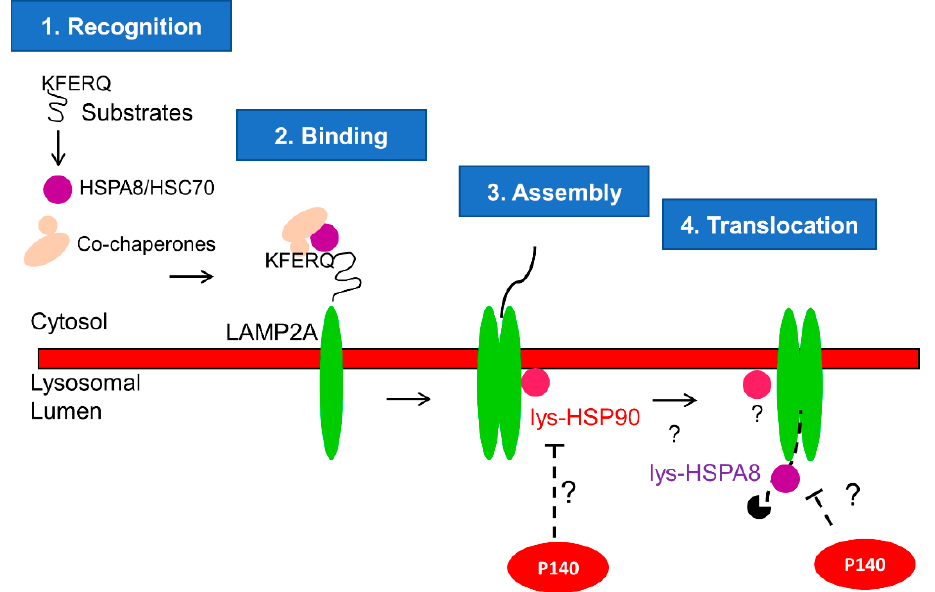
Figure 4. Proposed mechanism of P140 on CMA: CMA is a complex multistep process as described elsewhere in detail [17,18,36]. Here we focus on the CMA steps where P140 could play a role. Our results in this paper strongly suggest that P140 inhibits the substrate uptake step of CMA. The co-localization of P140 and HSPA8 was demonstrated earlier [24,27] by fluorescence and electron microscopy. It was not possible, however, to definitively determine that both co-localize into lysosomes or endosomes [27]. P140 interaction with HSPA8 was further demonstrated using surface plasmon resonance experiments and fishing experiments with living cells [23]. We place the e ff ect of P140 in the lysosomal lumen because we have previously shown that incubation of intact lysosomes with P140 in vitro does not modify CMA activity [22]. These findings are in agreement with P140 being internalized by endocytosis and reaching the lysosomal lumen through endolysosome fusion. The co-localization of P140 and LAMP2A has been demonstrated using fluorescence microscopy experiments [24]. Again, due to the resolution of images, it was not possible to definitively determine that that both co-localize within lysosomes. However, the results obtained in this work with a highly purified fraction of lysosomes active for CMA provide strong support of this compartment being the target of P140. Therefore, we hypothesize that the lysosomal P140 encounters and inhibits lysosomal HSP90 and HSPA8, which are responsible of the assembly of LAMP2A multiplex and translocation of CMA substrate, respectively.